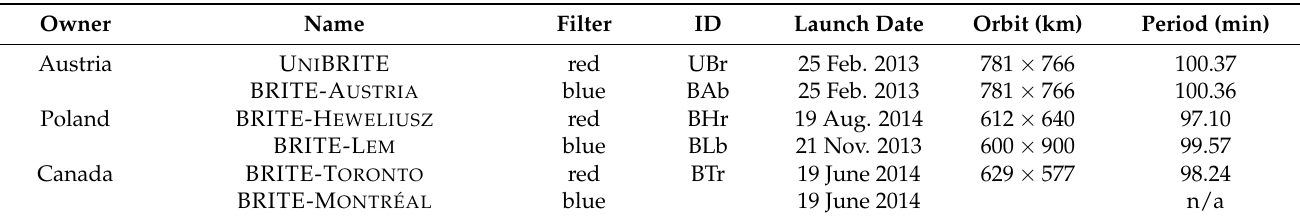
Table 1. Launch and orbital information for the BRITE nanosats. BRITE-M ONTRÉAL did not separate from the launch vehicle and is not operational. The red filter covers 550–700nm, and the blue filter 400–450nm.